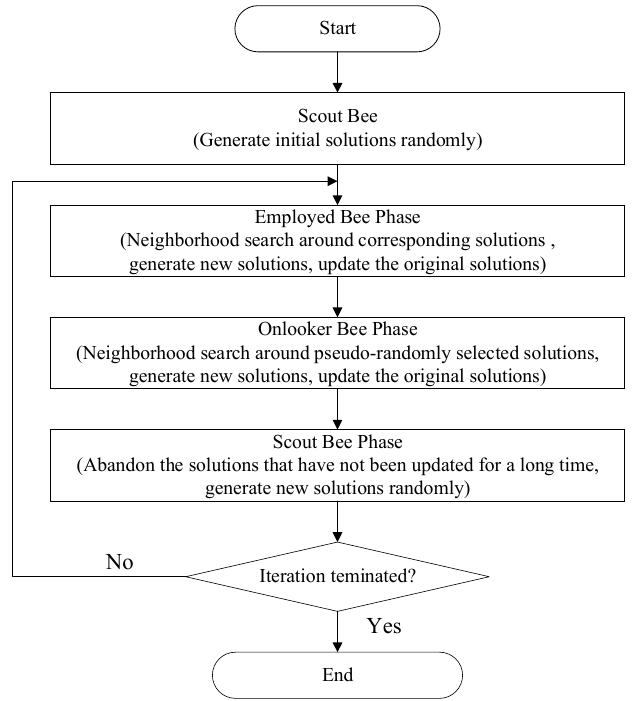
Figure 1 The procedure of the artificial bee colony (ABC) algorithm. Figure 1. The procedure of the artificial bee colony (ABC)